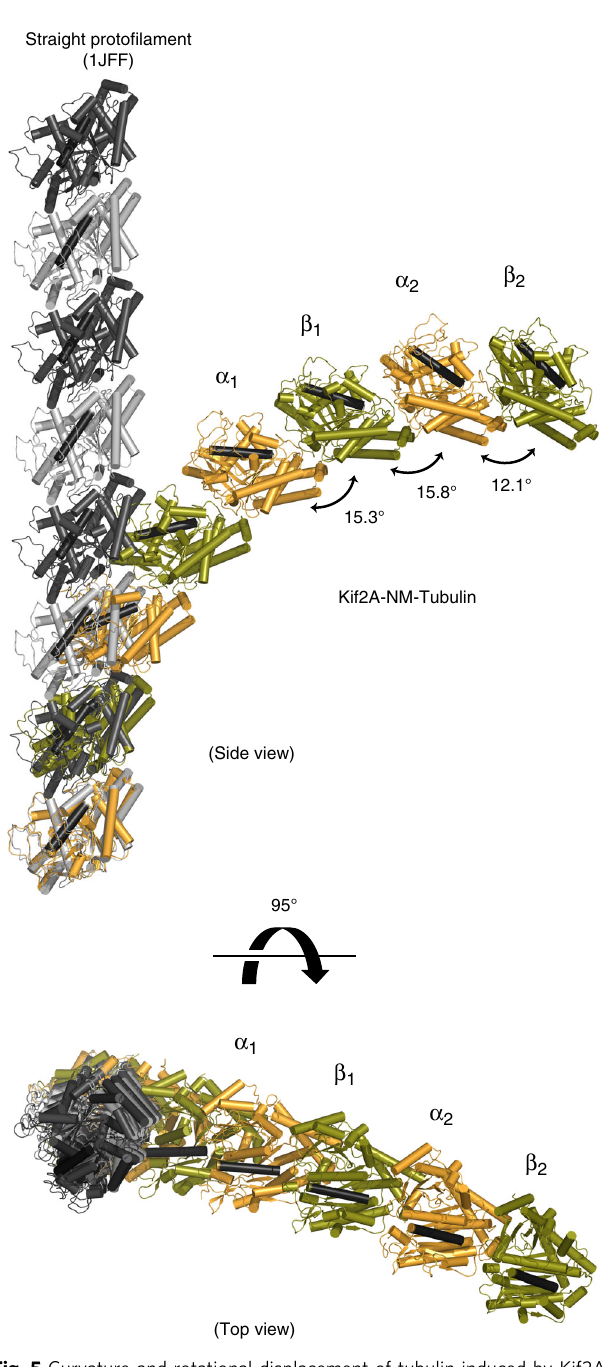
Fig. 5 Curvature and rotational displacement of tubulin induced by Kif2A- NM. Views are from the side and looking down the long axis of the straight proto fi lament model. Tubulin subunits of the Kif2A-NM – tubulin – DARPin complex (Kif2A and DARPin are not shown) are colored orange ( α -tubulin) and green ( β -tubulin), within which a single helix is colored black as a reference point. Straight proto fi lament structure ( α -tubulin in light gray, β - tubulin in dark gray PDB ID: 1JFF) is shown for reference. Extended proto fi laments were generated by aligning additional copies of each tubulin complex in an overlapping fashion. The degree of rotation between α - and β -tubulin subunits in the Kif2A-NM – tubulin – DARPin complex was determined from the transformation required to superimpose each subunit within, or between, each heterodimer using the RotationAxis plugin